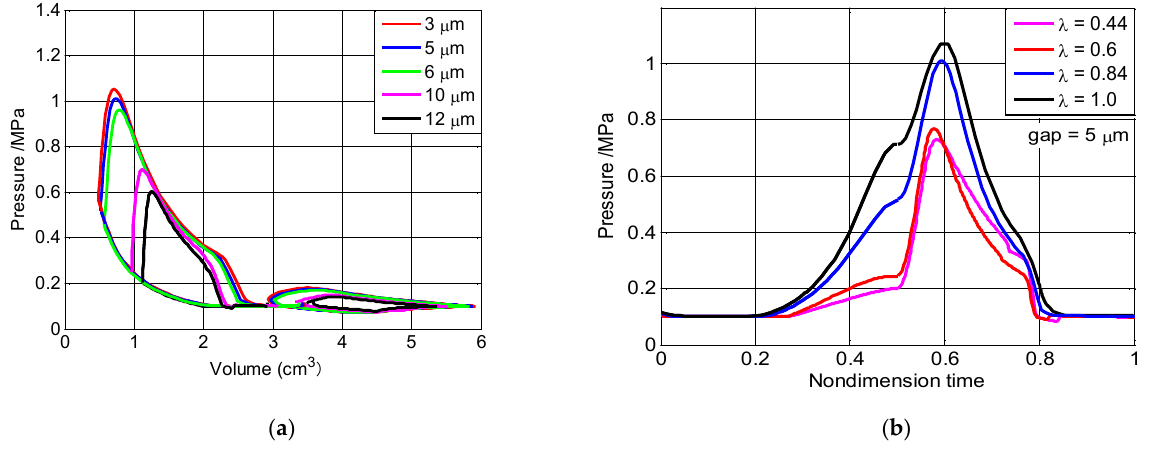
Figure 5. The influence of pressure ( a ) with volume of combustion/scavenge chambers for different seal gap heights; and ( b ) with the nondimensional time cycle for different size factors.